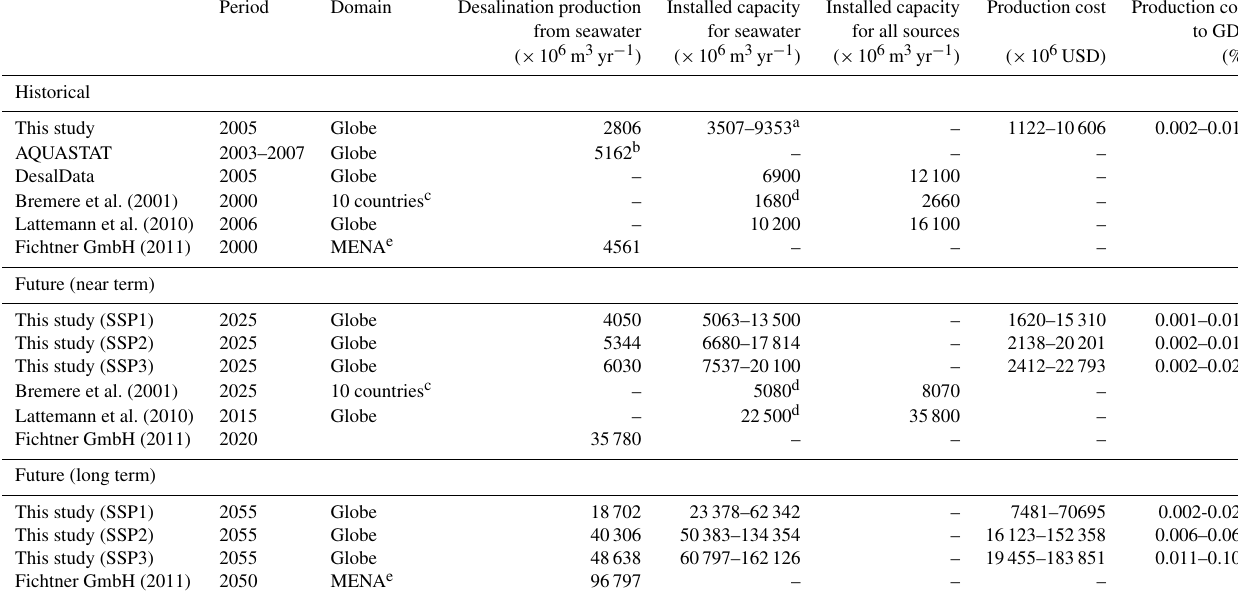
Table 4. Projected future production of desalinated water.